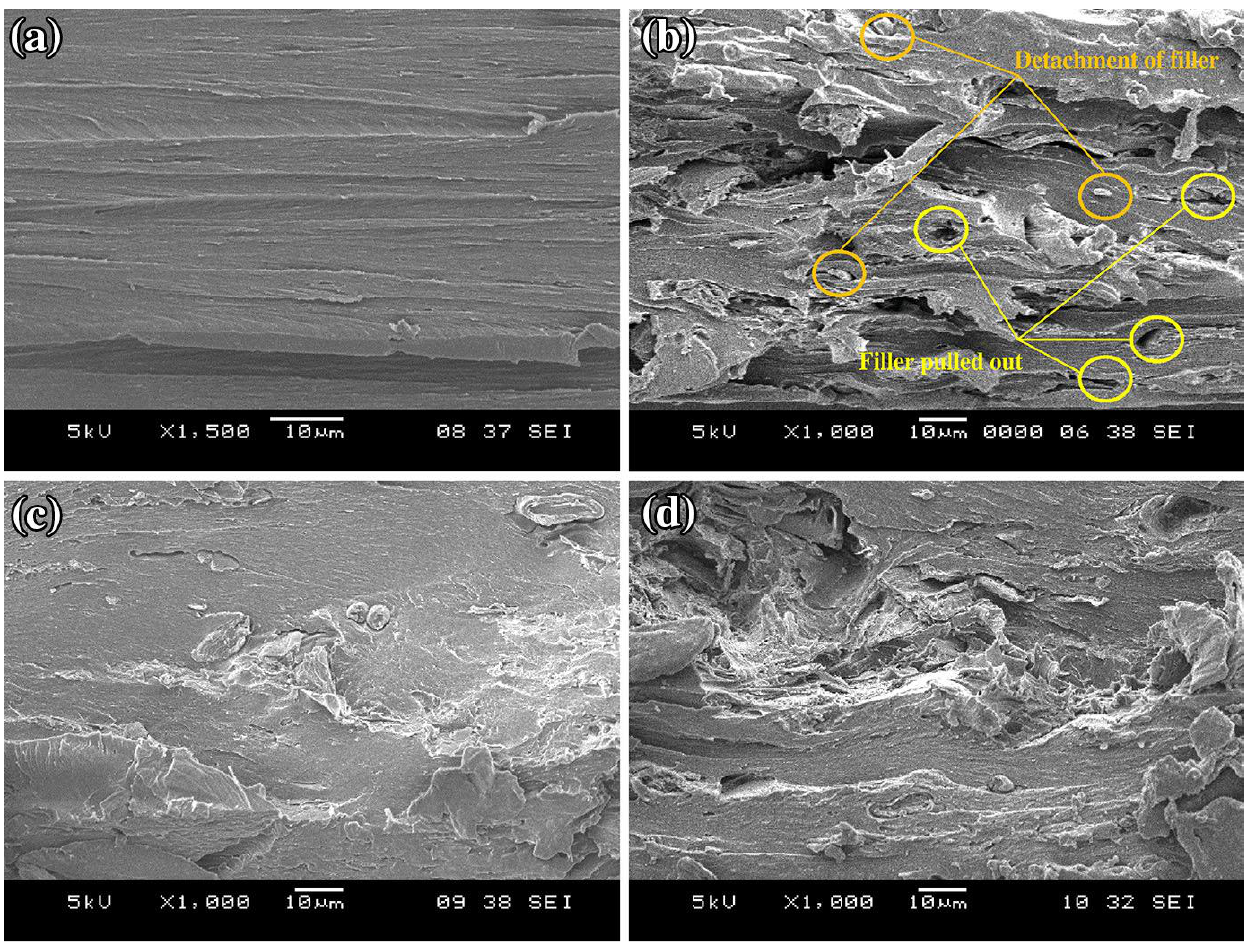
Figure 5. ( a ) SEM micrograph of neat CS; ( b ) SEM micrograph of unmodified CS/CC biocomposite film at 20 wt % of CC content; ( c ) SEM micrograph of modified CS/CC biocomposite film with ADP at 20 wt % of CC content; ( d ) SEM micrograph of modified CS/CC biocomposite film with EP at 20 wt % of CC content. Reprinted with permission from Ref. [22] , copyright 2022, Springer Nature.